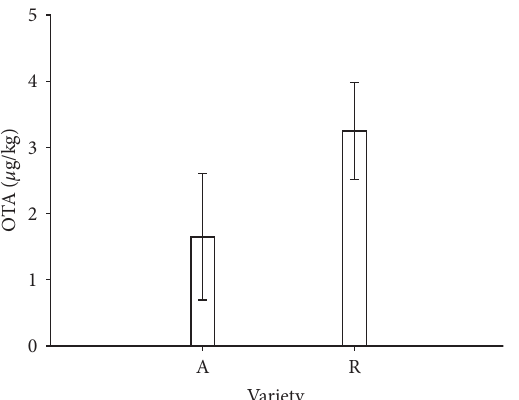
Figure 5: Mean OTA content of the two varieties of coffee sampled (R: robusta; A: arabica) in four Cameroonian